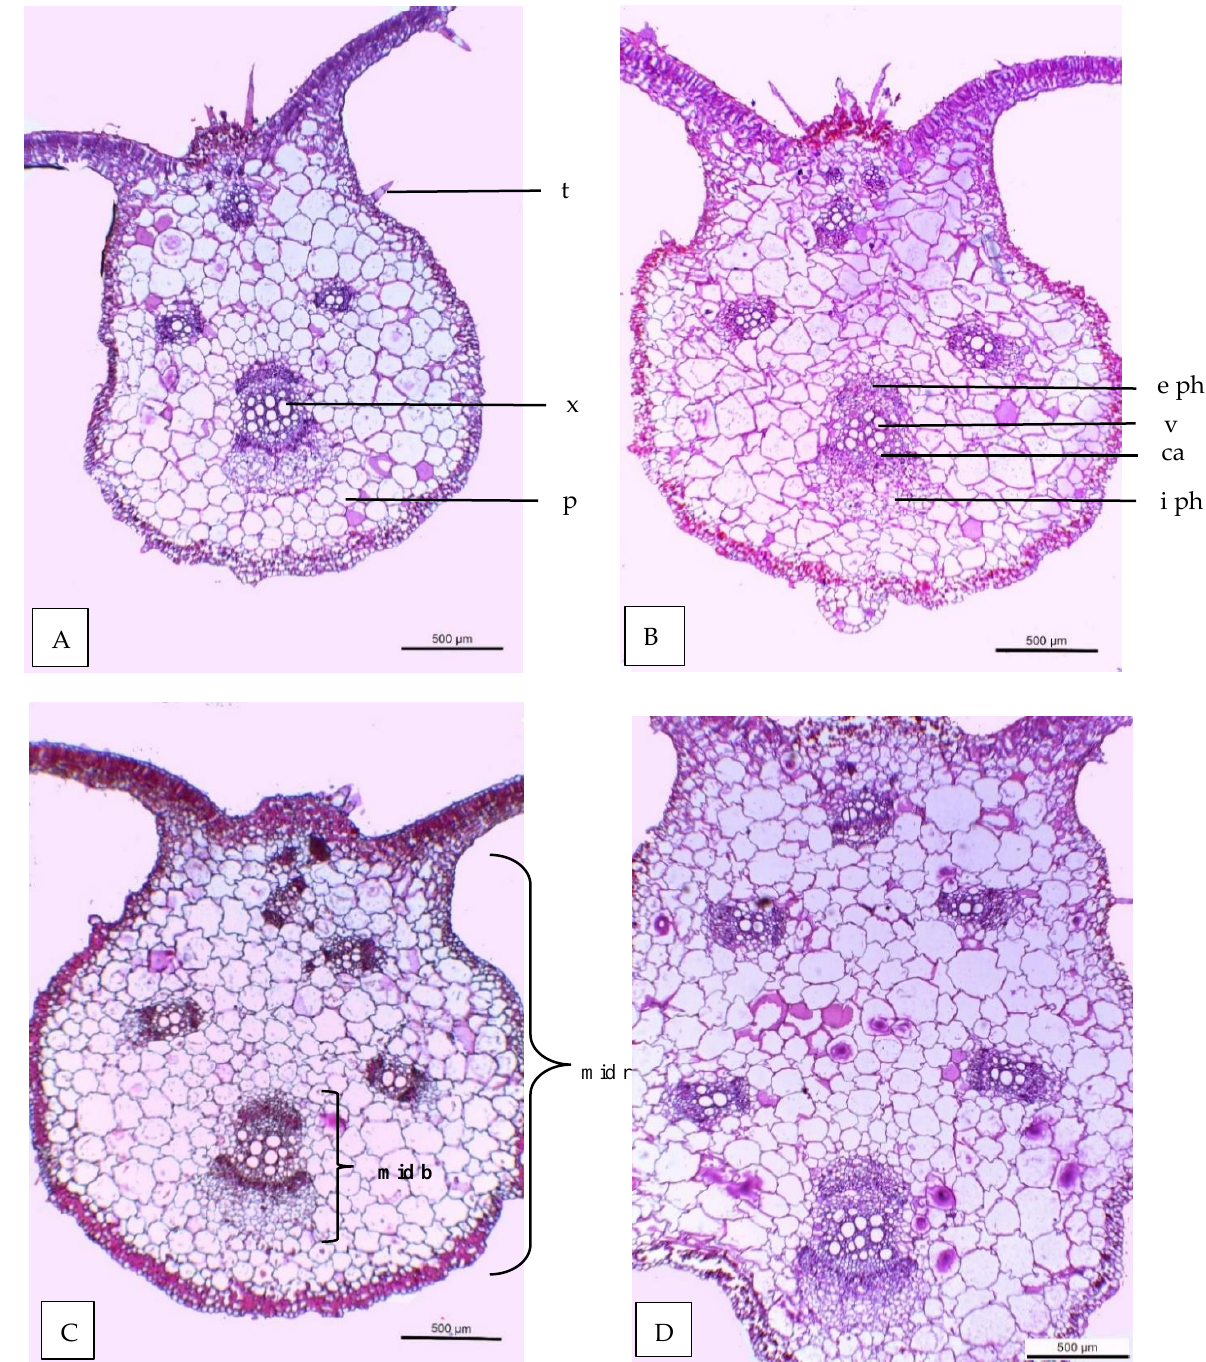
Figure 9. Microphotographs of cross sections through the blade of the fifth leaf developed on the main stem of summer squash (cv. Eskandarani), aged 50 days. Scale bars = 500 µ m. ( A ) Plants affected by powdery mildew (control). ( B ) Plants treated by 40 ppm shikimic acid (SA). ( C ) Plants treated by S. rochei + T. Asperullum (SR + TS). ( D ) Plants treated by mix between 40 ppm SA and (SR + TS). Abbreviations: mid b—midvein bundle; mid r—midvein region; t—trichome; p—paranchyma cells; ca—cambium zone; e ph—external phloem; i ph—internal phloem; v—vessels; and x — xylem.